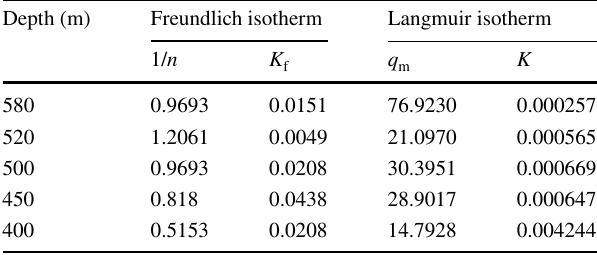
2 sorption isotherm model at 27 °C